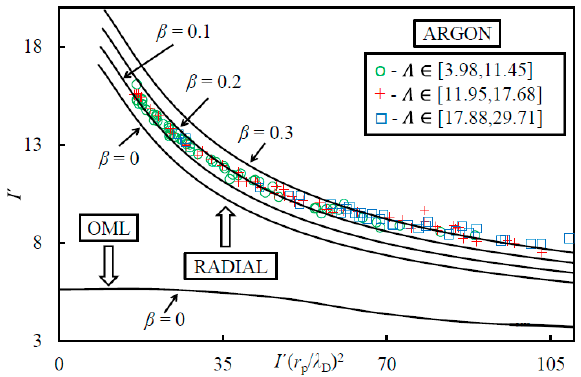
Figure 1. Argon plasma Sonin plot for the normalized probe potential y SP = 25. Experimental data for the argon plasma: green circles for 3.98 ≤ Λ ≤ 11.45, red crosses for 11.95 ≤ Λ ≤ 17.68 and blue squares for 17.88 ≤ Λ ≤ 29.71. In solid lines, the orbital and radial theoretical curves are shown.